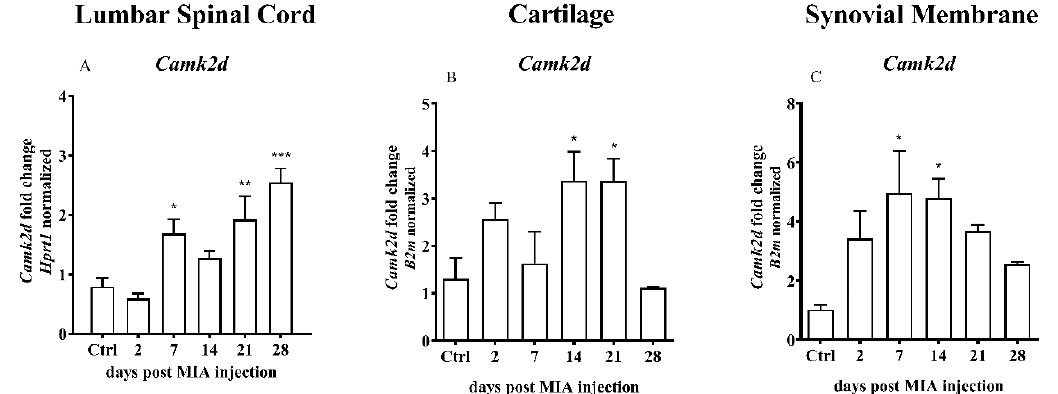
Figure 8. Transcript levels of calcium / calmodulin-dependent protein kinase II delta ( Camk2d ) in the ( A ) lumbar L4–L6 spinal cord segments, ( B ) cartilage and ( C ) synovial membrane of rats after 3 mg MIA injection during OA development. The samples were collected 2, 7, 14, 21 and 28 days after MIA injection; the control group did not receive any treatment. The groups contained 6–9 samples (for the spinal cord analysis) or 3 - 6 samples (for the cartilage / synovial membrane analysis). Data are presented as the mean ± SEM of fold changes of the group average normalized versus the reference gene ( Hprt1 or B2m ). Statistical analysis was performed using one-way ANOVA followed by Dunnett post hoc-test (intact animals treated as a control group). * denotes p < 0.05; ** denotes p < 0.01; *** denotes p < 0.001 vs. intact animals.